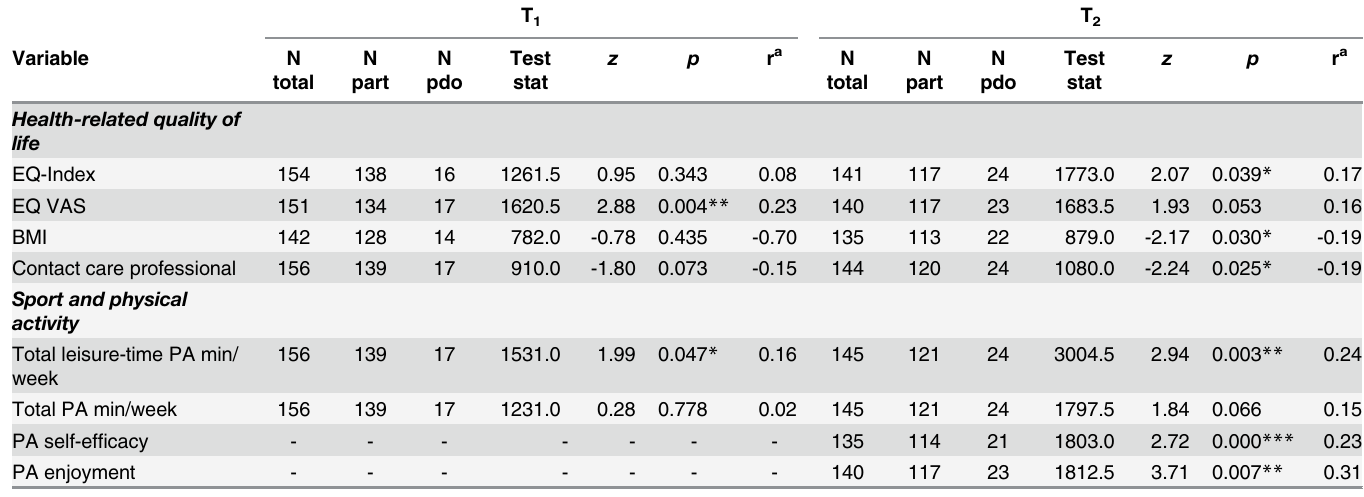
Table 6. Differences between participants (part) and program dropouts (pdo) in PA behaviour and health-related quality of life at T 1 and T 2 ( z- approximation of Mann – Whitney U test). T